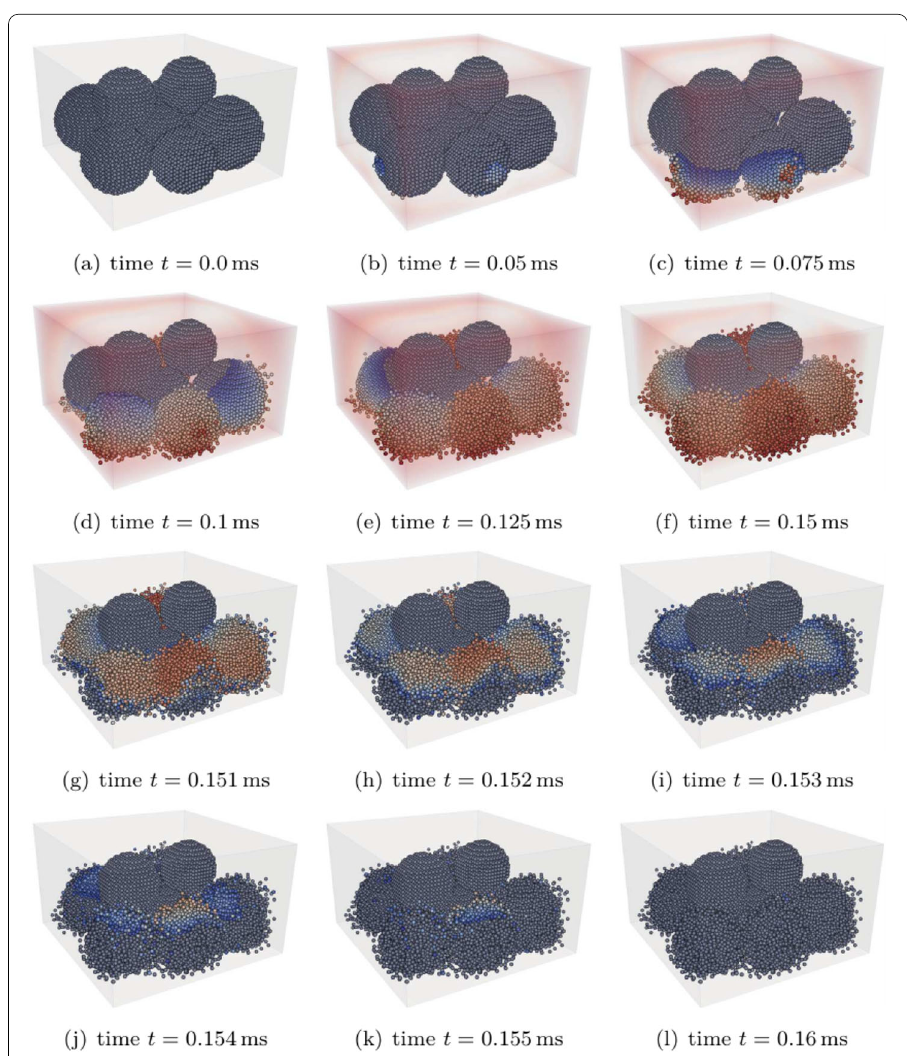
Fig. 14 Three-dimensional powder melting setup with representative material parameters: time series of the obtained results with temperature field ranging from 1700K (blue) to 1800K (red)